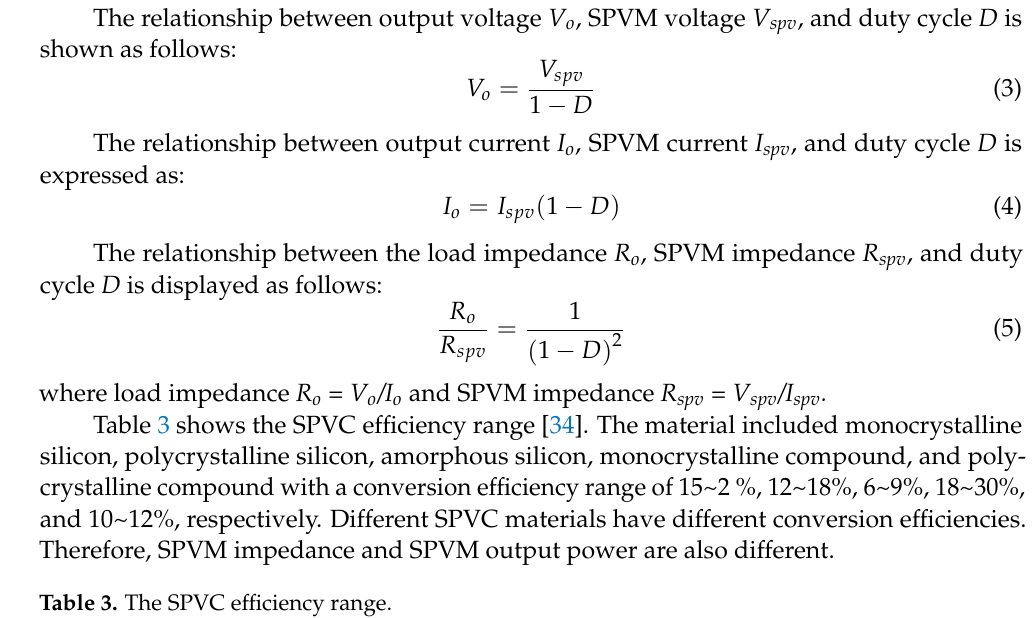
Table 3. The SPVC efficiency range. SPVC Material Conversion Efficiency Range Monocrystalline silicon 15~20%